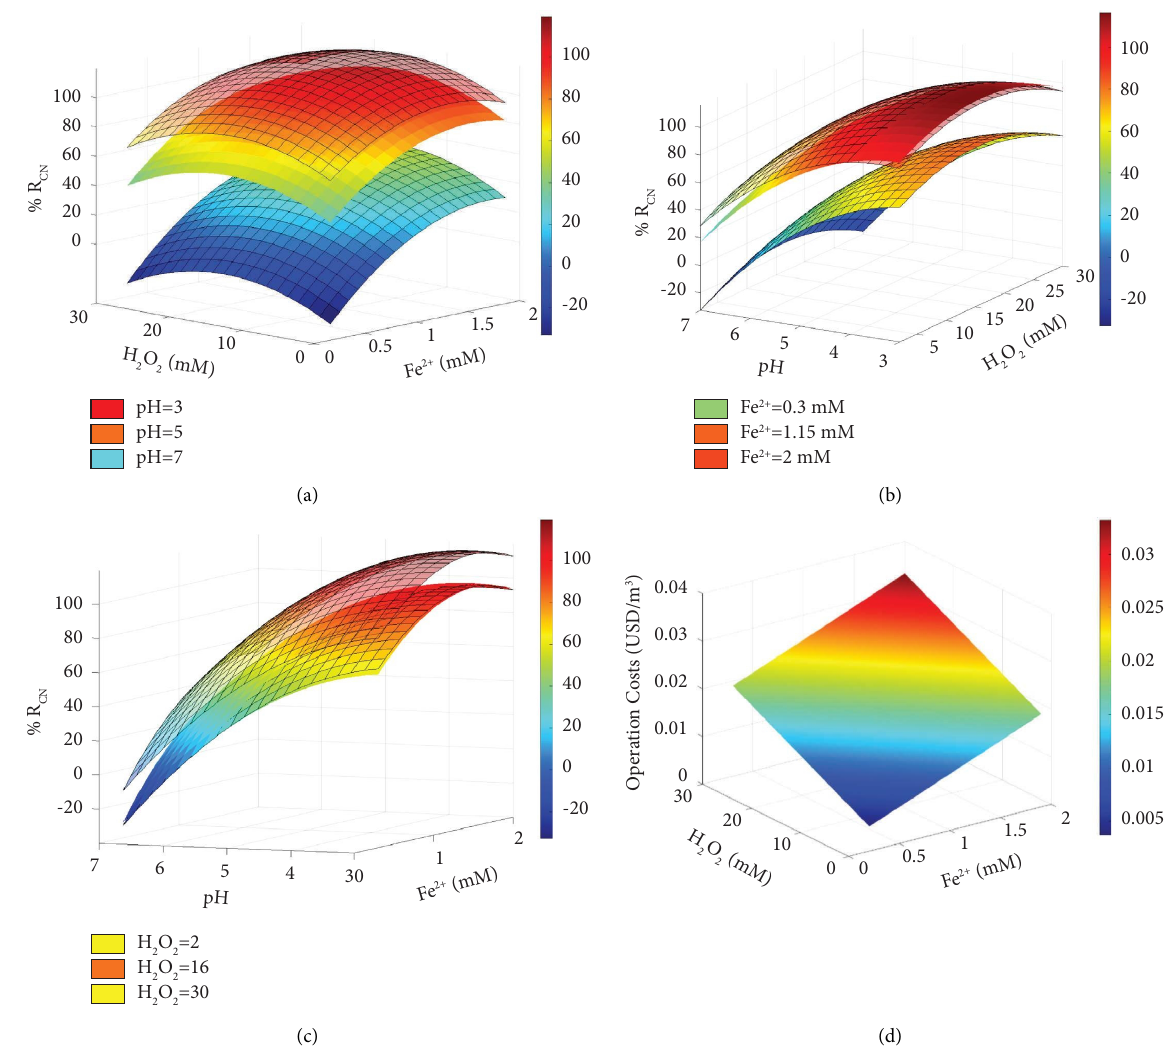
Figure 5: Tree-dimensional plots of surface response for the interactive efect of pH, [Fe 2+ ], and [H